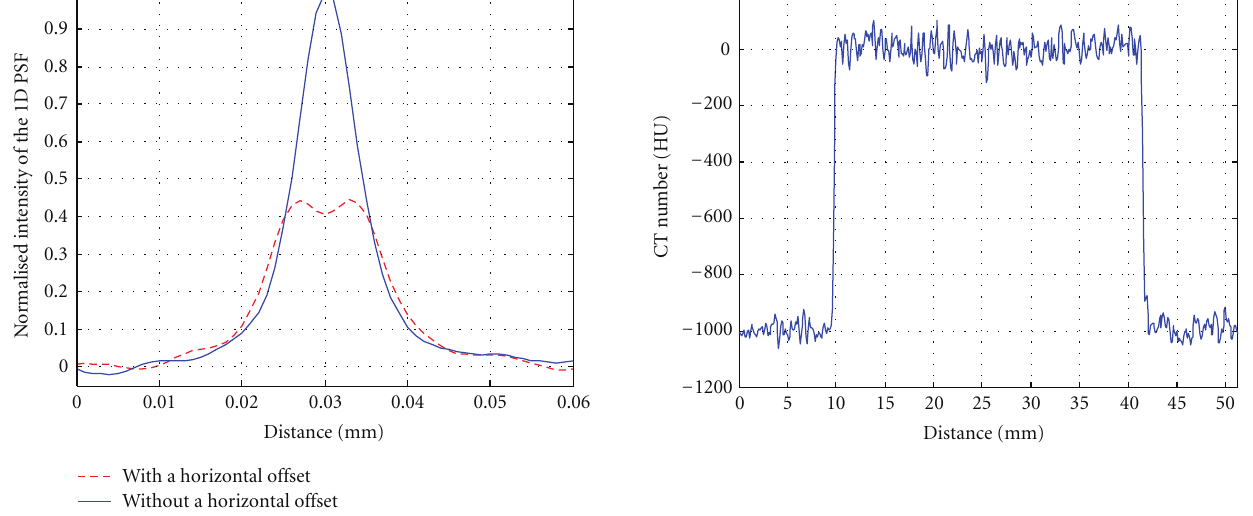
Figure 7: 1D point spread function with and without a horizontal o ff set.